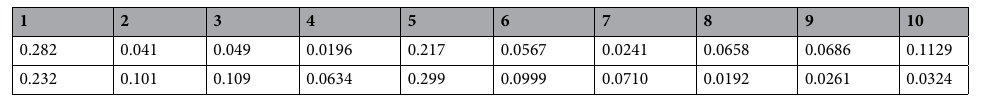
Table 3. Confidence interval for the difference in entropy means of pre-intake and post-intake comparison, returned as a two-element vector containing the lower and upper boundaries of the 100 × (1 – Alpha)% confidence